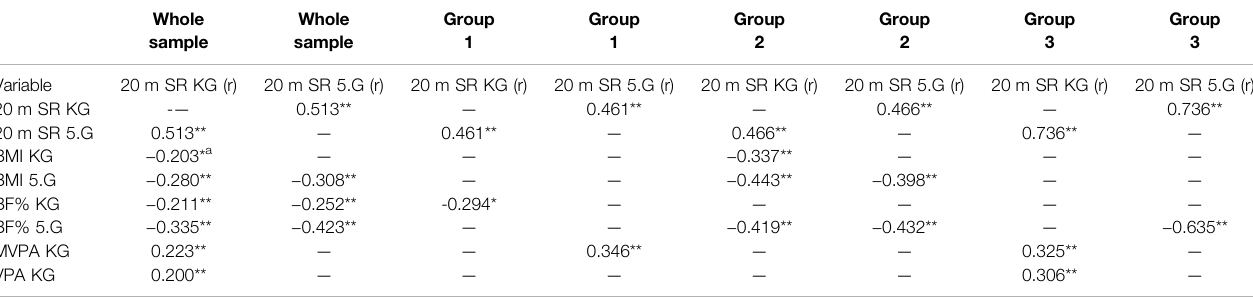
TABLE 3| Statisticallysigni fi cantassociationsbetween 20-m shuttlerun results, body compositionsindices,and physical activity in kindergarten and 5thgrade in groups of study participants according to organized sports participation. Whole Whole sample